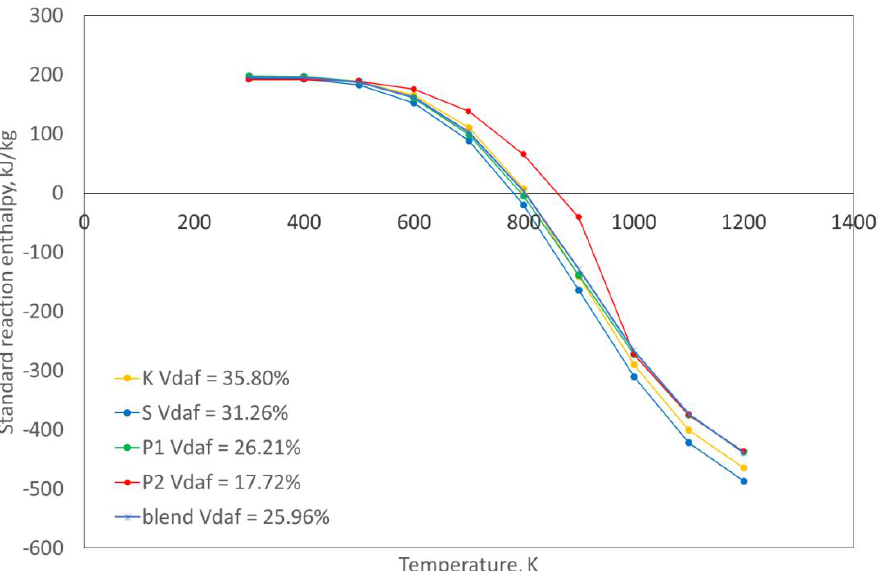
Figure 3. The change in the standard enthalpy of pyrolytic reaction with the temperature increase.